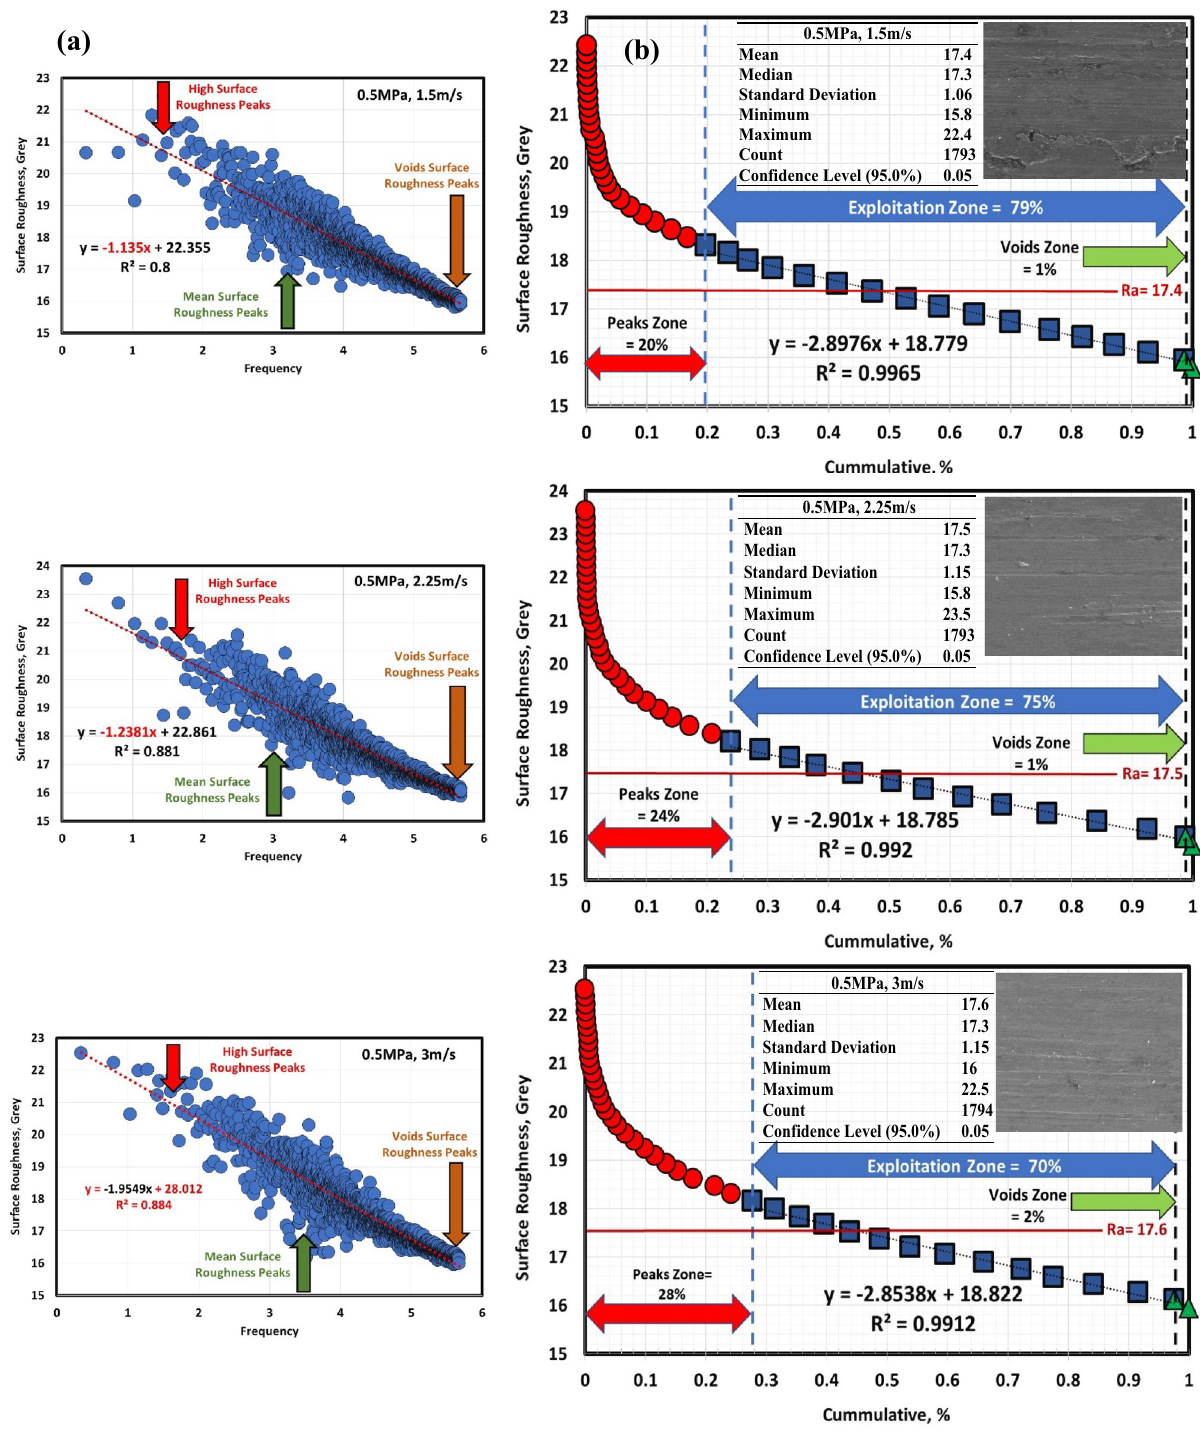
Figure 6. ( a ) Surface texture, ( a,b ) Abbott Firestone curves at 0.5 MPa and different velocities of